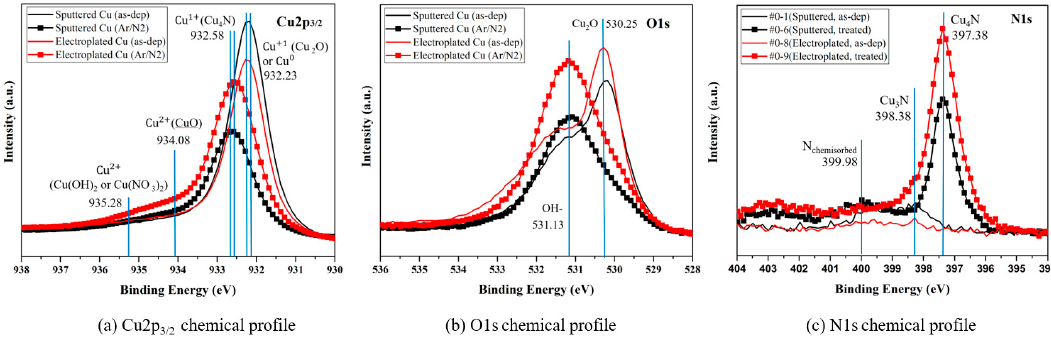
Figure 5. XPS analysis: ( a ) Cu2p, ( b ) O1s, ( c ) N1s.